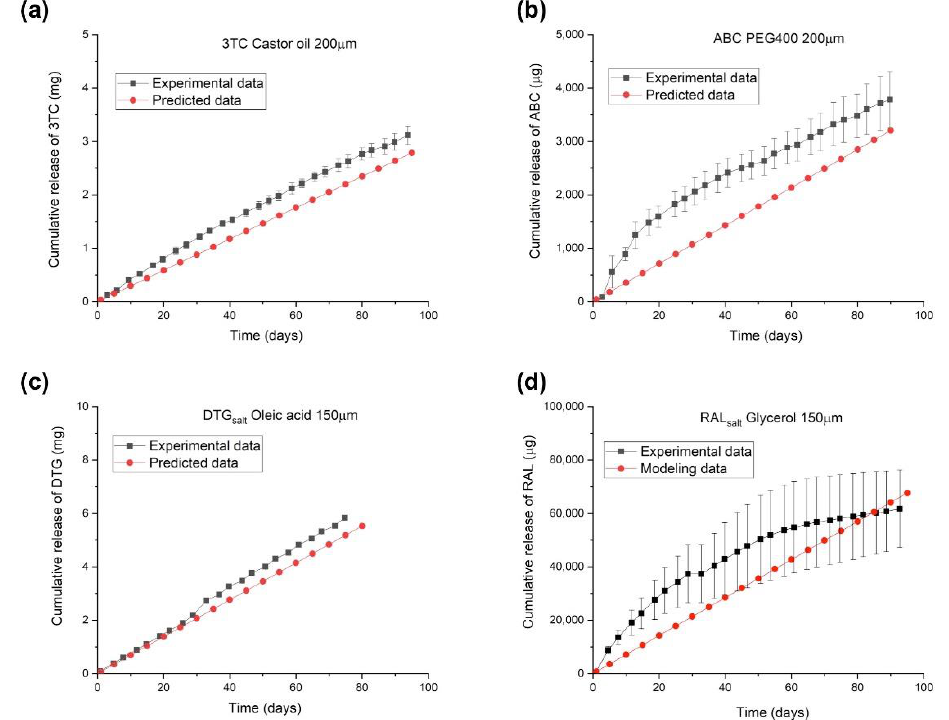
Figure 5. Predicted and experimental release profiles of implants containing a single ARV with individual configurations: ( a ) 3TC (castor oil, PC- 17, 40 mm length, 200 μm wall thickness, drug to excipient ratio: 2:1), ( b ) ABC (PEG 400 , PC- 17, 10 mm length, 200 μm wall thickness, drug to excipient ratio: 2:1), ( c ) DTG salt (oleic acid, PC- 31, 10 mm length, 150 μm wall thickness, drug to excipient ratio: 2:1), and ( d ) RAL salt (glycerol, PC- 31, 40 mm length, 150 μm wall thickness, drug to excipient ratio: 2:1).